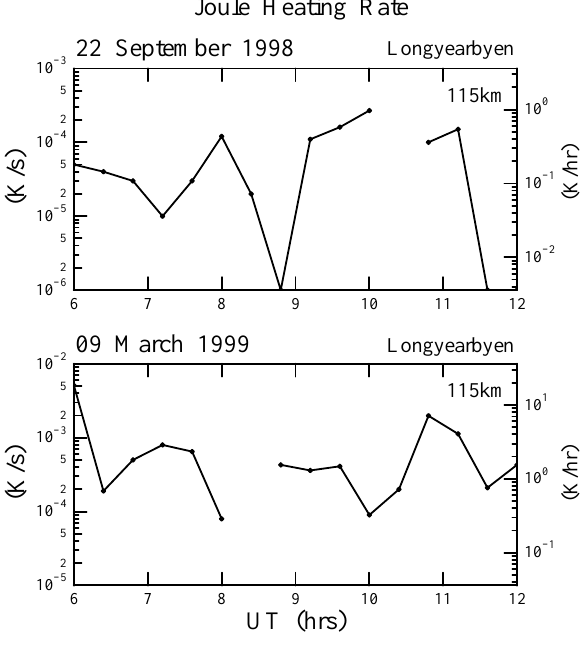
Fig. 12. Joule heating rate at 115km altitude at Longyearbyen from 06:00 to 12:00UT on 22 September 1998 (top) and 9 March 1999